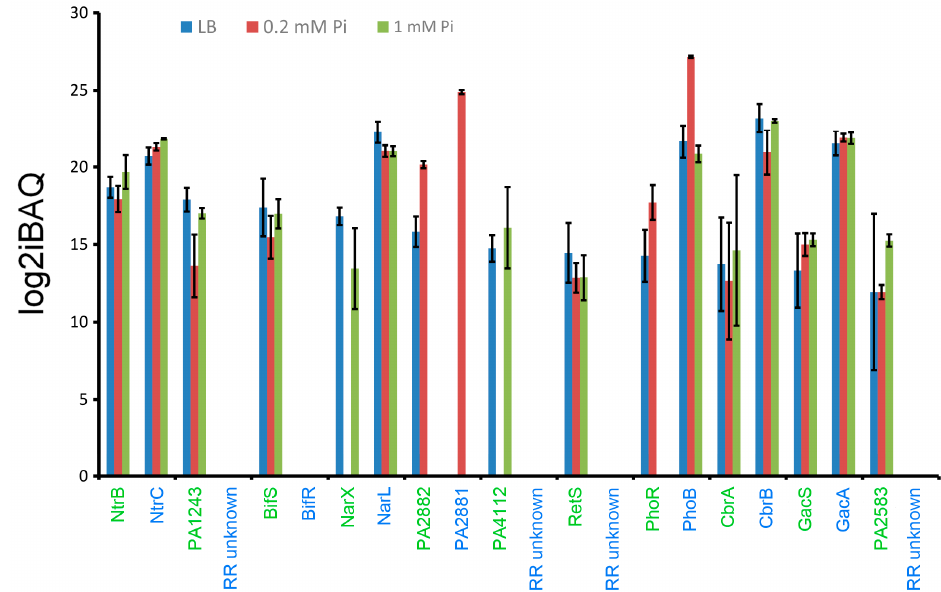
Figure 5. Amounts of sensor histidine kinases and response regulators of P. aeruginosa PAO1 grown in LB medium or minimal medium with 0.2 mM and 1 mM Pi. Data are ordered according to the protein amounts of sensor histidine kinases in LB. Sensor histidine kinases are annotated in green and their cognate response regulators in blue. Error bars indicate standard deviations from the mean intensity Based Absolute Quantification (iBAQ) index.